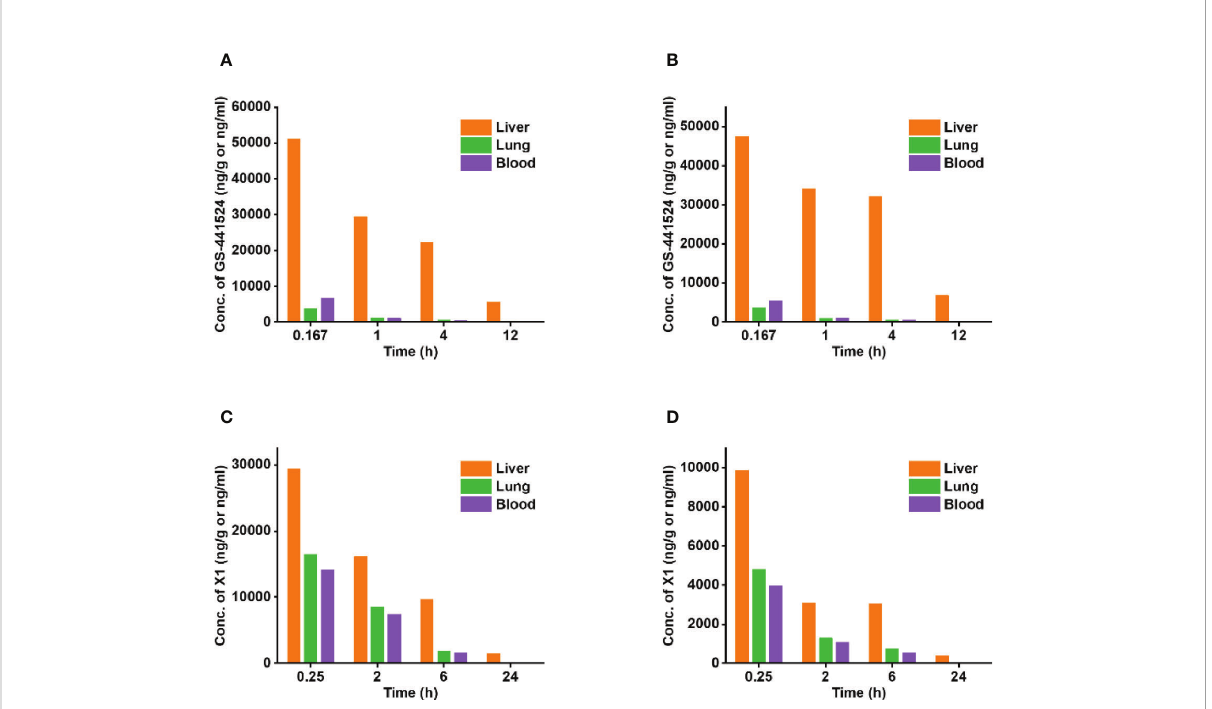
FIGURE 4 The concentration distribution of the key metabolites, GS-441524 and X1, in the liver, lungs, and blood in rats or mice. Oral VV116 administration can circumvent liver-targeting issues. (A) The concentration of [14C] GS-441524 in the liver, lungs, and blood following intravenous administration of [14C] remdesivir at a single dose of 10 mg/kg in male SD rats. (B) The concentration of [14C] GS-441524 in the liver, lungs, and blood following intravenous administration of [14C] remdesivir at a single dose of 10 mg/kg in male Long Evans rats. (C) The concentration of X1 in the liver, lungs, and blood following oral administration of VV116 at a single dose of 100 mg/kg in Balb/c mice. (D) The concentration of X1 in the liver, lungs, and blood following oral administration of VV116 at a single dose of 30 mg/kg in SD